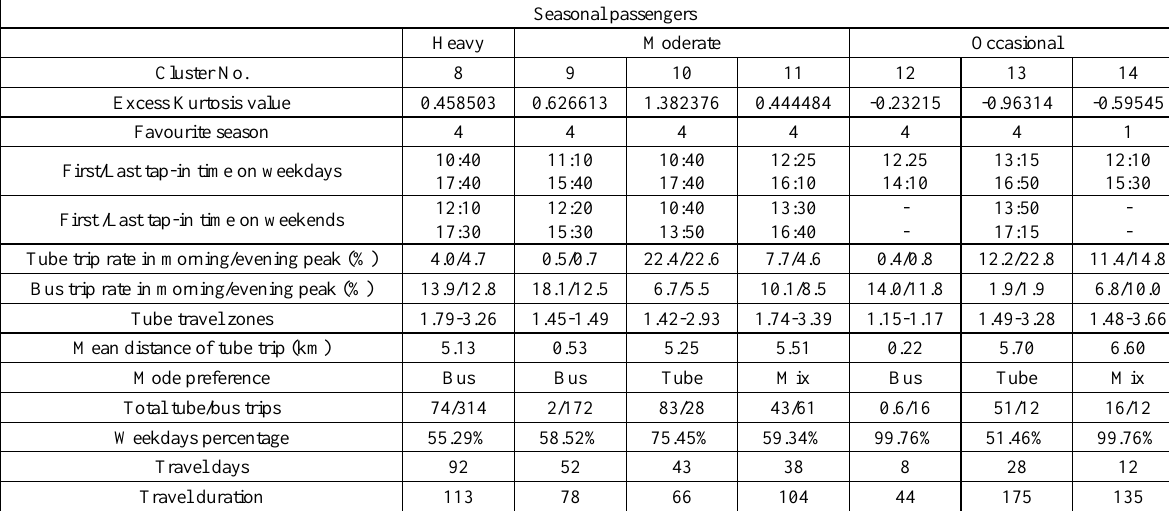
Table 4. Some selected travel features of seasonal